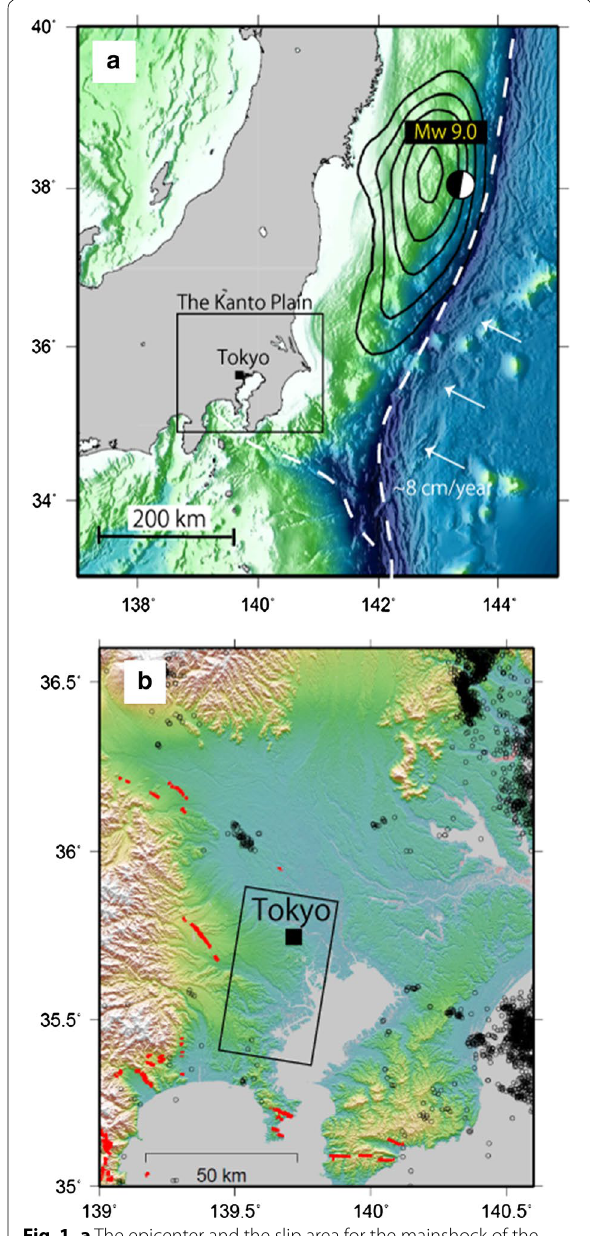
Fig. 1 a The epicenter and the slip area for the mainshock of the 2011 Tohoku earthquake overlaid on seafloor topography. Contour lines are the 5-m interval slip distribution of the mainshock (Ozawa et al. 2011), and a black square represents the Kanto Plain. A black rectangle indicates the studied area, which corresponds to Figs. 2 and 3. b Topography of the Kanto Plain. A black square is the location of Tokyo. Red lines are active fault traces plotted according to Nakata and Imaizumi (2002), and black dots are the locations of aftershocks that occurred from March 11, 2011, to December 31, 2011. A black rectangle in ( b ) is the covered area of TerraSAR-X